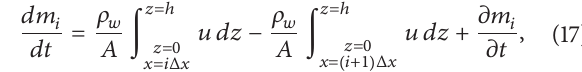
where 𝑐 denotes the current face where the particle locates, ℎ denotes the current film height where the particle locates, ∇ 𝑠 is the gradient operator as to the surface, 𝑝 𝑓 is the film pressure, 𝜏 𝜏 𝑔 and 𝑤 are, respectively, the magnitude of the shear stress of the air flow on the film surface and the magnitude of the 󳨀⇀ 󳨀⇀ 𝑡 𝑡 stress of the film exerted by the wall. 𝑔 and 𝑤 are the unit vectors in the direction of the relative motion of the film and ̇󳨀⇀ 𝑃 the wall, denotes the impingement pressure on the film imp ,𝑐 ̇󳨀⇀ ̇𝑀 𝐹 surface, is the impingement momentum source, 𝑛,𝑐 is imp ,𝑐 ℎ(󳨀⇀ 󳨀⇀ 𝑔 − 𝑎 ) is the force to keep the film on the surface, and 𝜌 𝑎 𝑤 󳨀⇀ 𝑎 the body force term in which 𝑤 is the acceleration of the relative wall